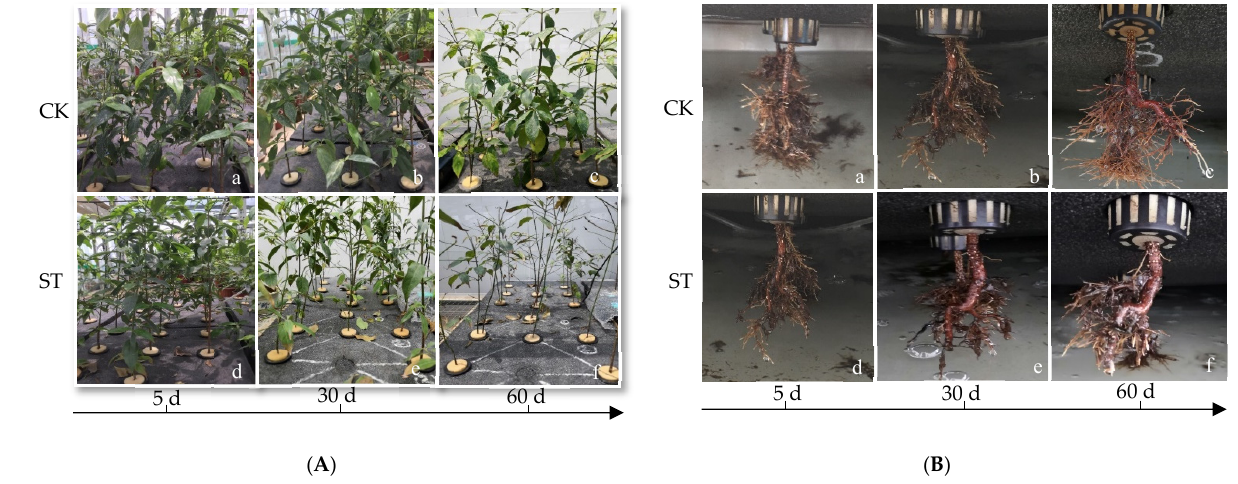
Figure 1. Leaves and roots growth performances of C. hongkongensis subsp. tonkinensis seedlings grew in the nutrient solution without (CK)/with (ST) 0.3% salt on the days of 5th, 30th, and 60th. ( A , B ) represent leaves and roots; ( a – c ) represents seedings of CK, ( d – f ) represents seedings of salt ‐ treated (0.3% salt), respectively.